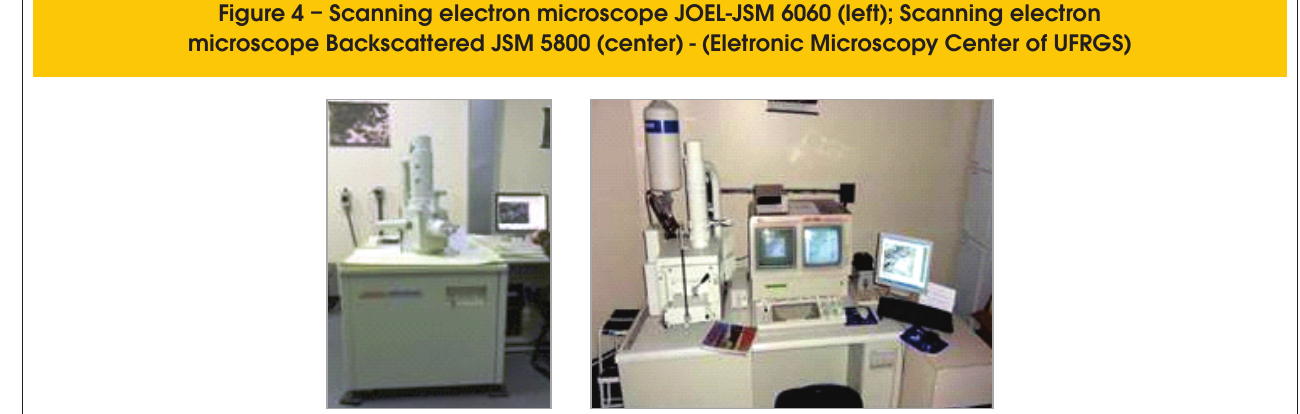
Figure 4 – Scanning electron microscope JOEL-JSM 6060 (left); Scanning